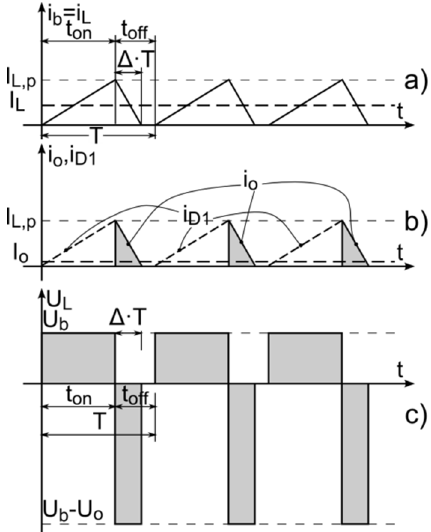
Figure 7. Layout 1 discharge operation: current and voltage waveforms (discontinuous